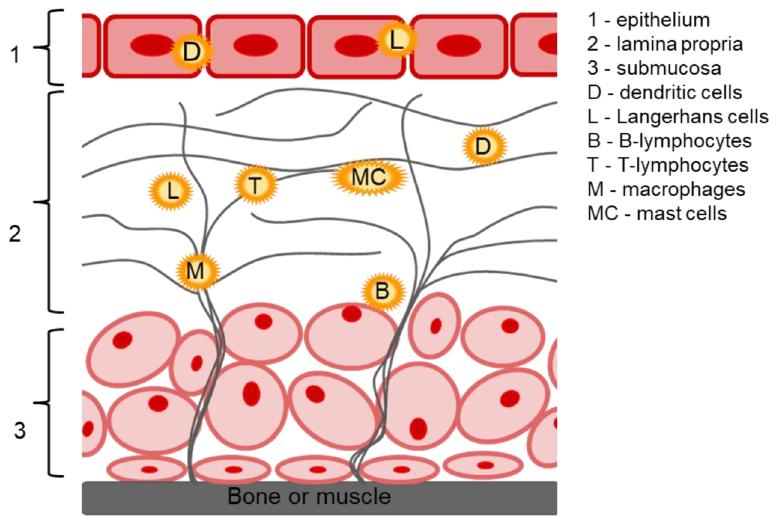
Figure 2. The structure of oral